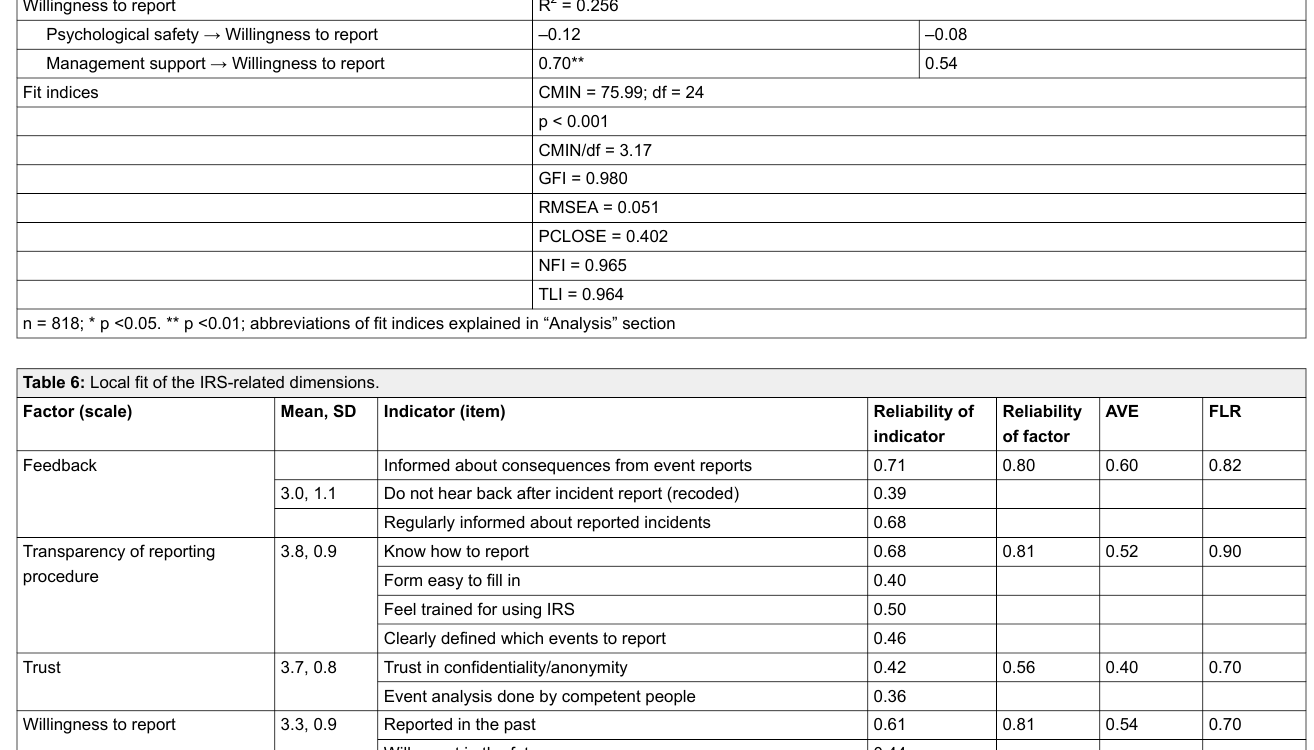
Table 5: Path coefficients and general fit indices of the structural model: organisational influences. Willingness to report